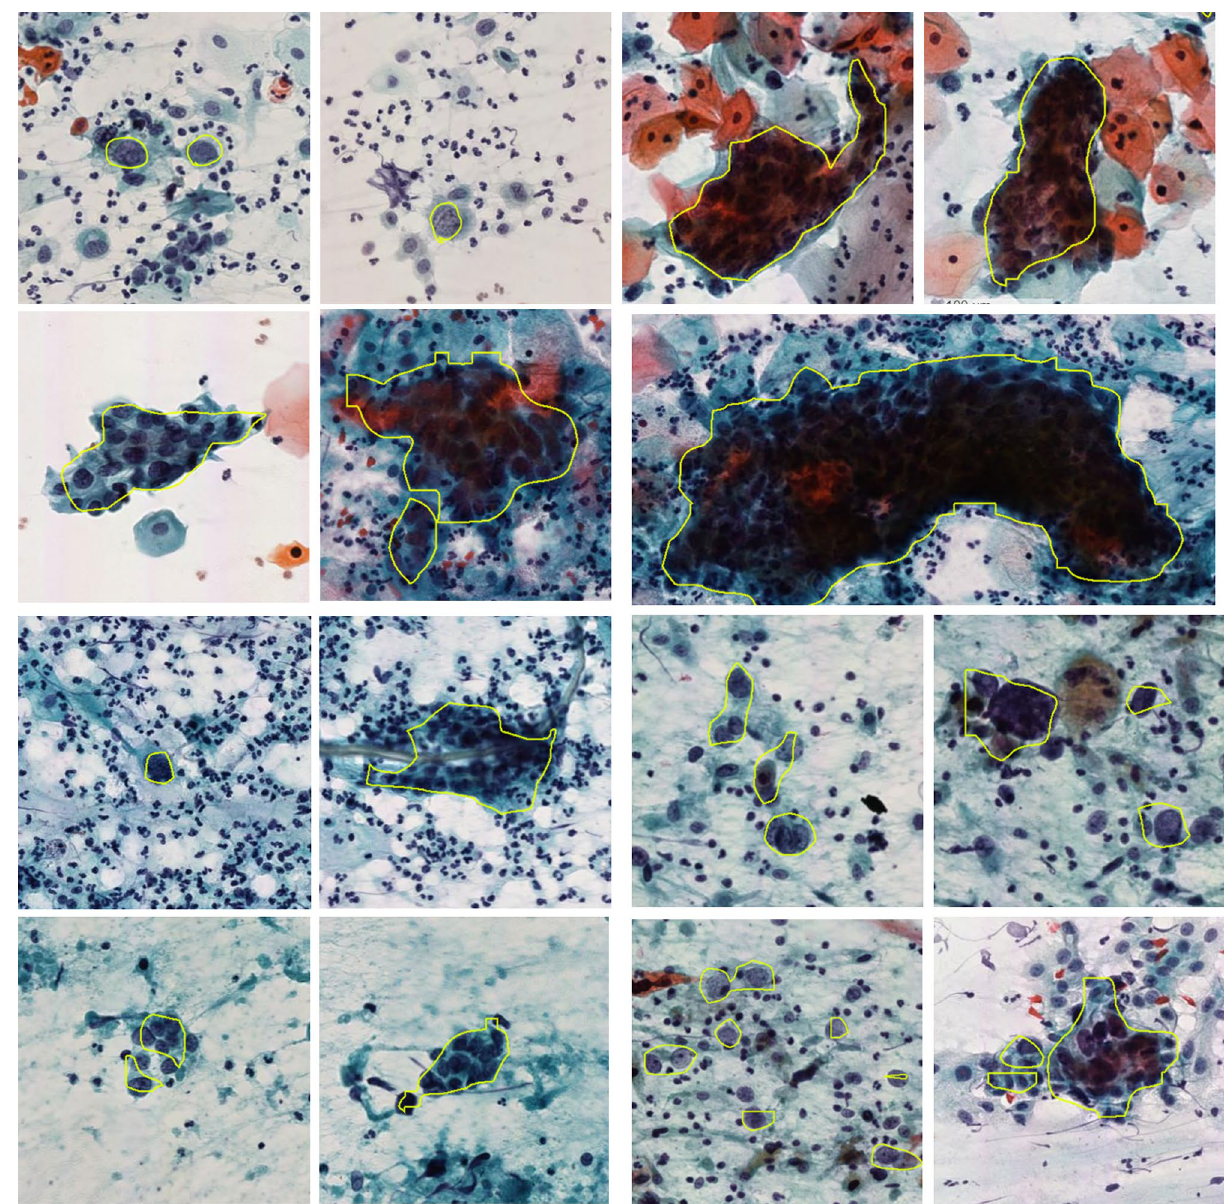
Figure 1. Segmentation results of randomly selected examples by the proposed method where the HSILs are highlighted in instead trained and tested using non-overlapping tiles (512–512 pixels) obtained from the WSIs. Distribution of the tile numbers per WSIs as shown in Fig. 2b. In computational pathology, the massive size of WSIs is one of the challenges. For automatic analysis the average size of WSIs is 91,257 × 41,546 pixels, 45.93 × 20.91 mm in our dataset, and the size distribution of the WSIs as shown in Fig. 2c. The proposed network structure with the asso- ciated outputs of the selected layers are shown in Fig. 2d. A WSI generally contains billions of pixels, while the regions of interest could be as small as a few thousands of pixels (see Fig. 2e). We collected slide-level reviews and region-level annotations from pathologists. Slide-level reviews categorize each slide into a group of higher than LSIL including ASC-H, HSIL and SQCC. Region-level annotations represent specific HSILs or higher (SQCC) within a slide. The information for the dataset is shown in Table 1. Experimental set‑up and implementation details. In evaluation, the whole slide images were ran- domly split into two sets: 68% for training and 32% for testing. As shown in Table 1, the training set consists of 25 ASC-H, 57 HSIL, and 15 SQCC cases, and the tiles annotated and sampled for building AI models account for 0.006% of the training WSIs and for 0.004% of the whole data set, respectively. Moreover, the proposed framework is initialized using VGG16 model, and stochastic gradient descent (SGD) optimization and the cross entropy loss function are utilized. In addition, the network training parameters of the proposed method, includ-